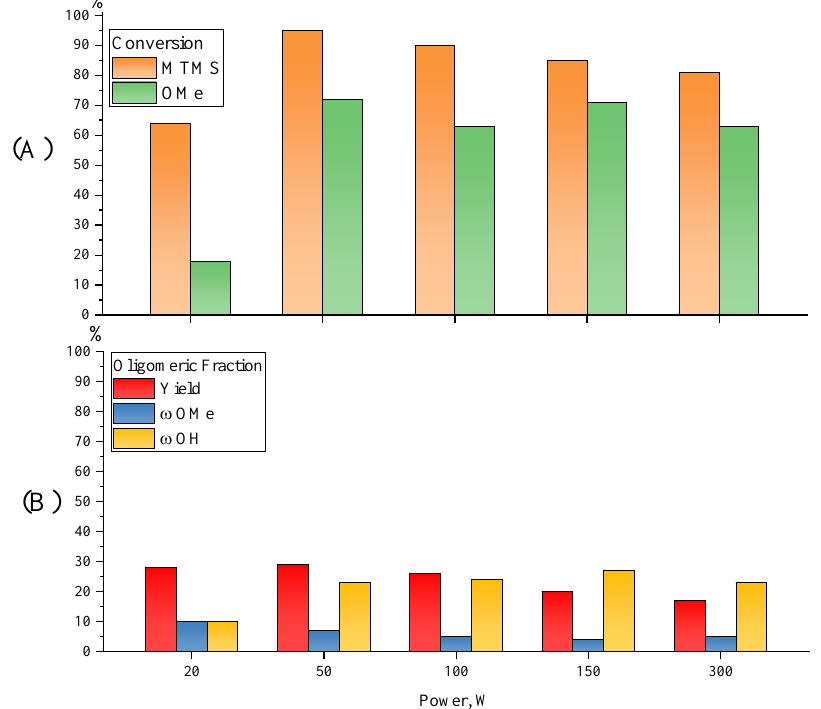
Figure 12. GPC curves for the oligomeric fraction obtained by MTMS MWHP at different radiation times and an MTMS/H 2 O molar ratio of 1/1.5, at 20 W for 5 min (Samples 7, 16–17, Table 1). The composition of the products obtained by the catalytic-free hydrolytic polycon- densation of MTMS under MW radiation insignificantly depend on the radiation power (Samples 7, 18–21, Table 1; Figures 13 and 14).